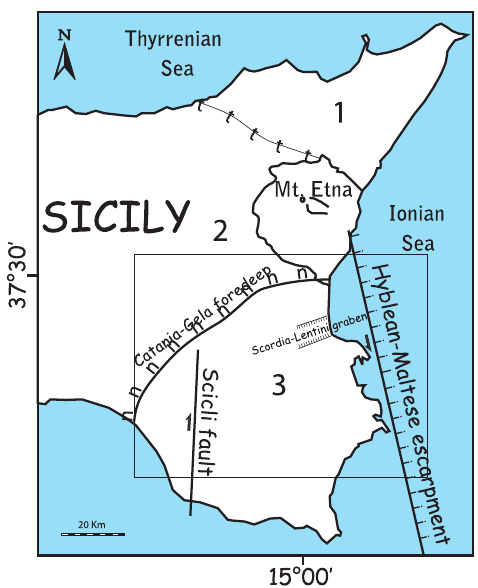
Fig. 1. Sketch of the structural setting of Eastern Sicily. 1 = Crystalline units of the Calabrian arc; 2 = units of the Maghrebian arc; 3 = Hyblean plateau. The box indicates the spatial distribution of the GPS network described in this